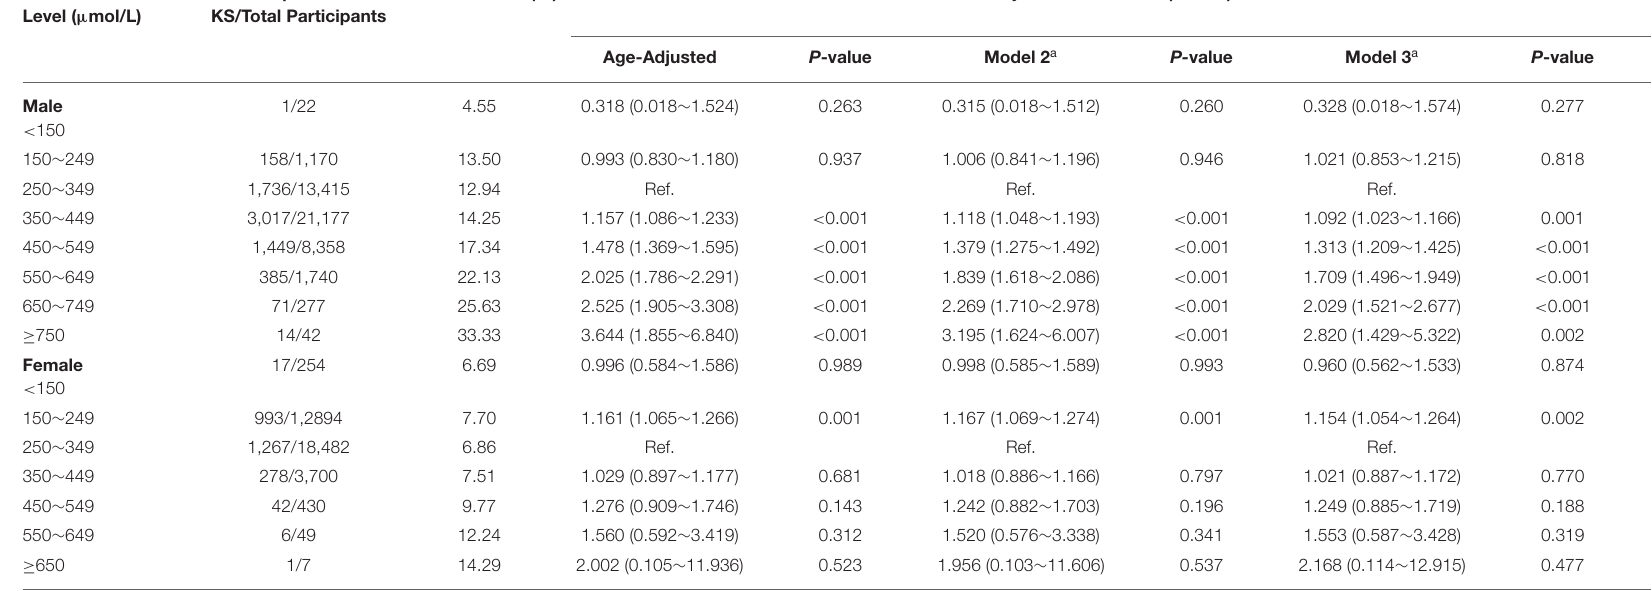
TABLE 2 | Odds ratio ( OR ) for KS stratified by UA level and sex. Stratified Uric Acid Participants with Incidence Rate Level ( µ mol/L) KS/Total Participants